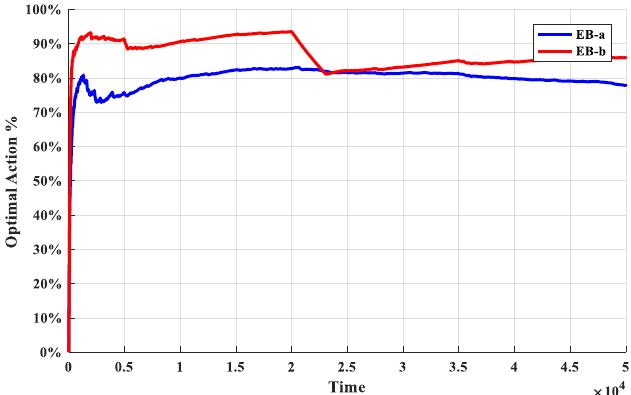
Figure 8. The optimal arm utilization rate of different policies for different scenarios.